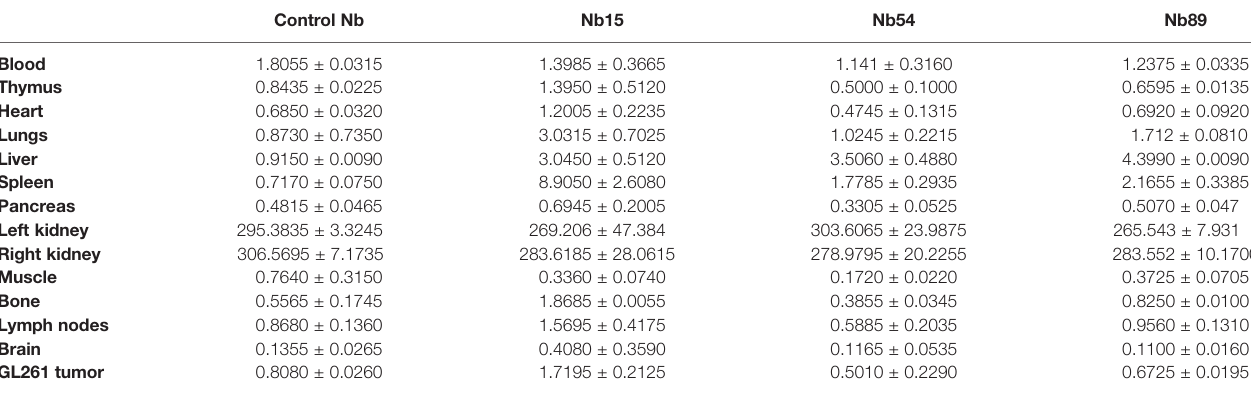
TABLE 1 | Uptake values of 99m Tc-labeled control Nb R3B23 or anti-SIRP a nanobodies in GL261 tumor-bearing mice based on dissection at 1 h 45 min post injection.